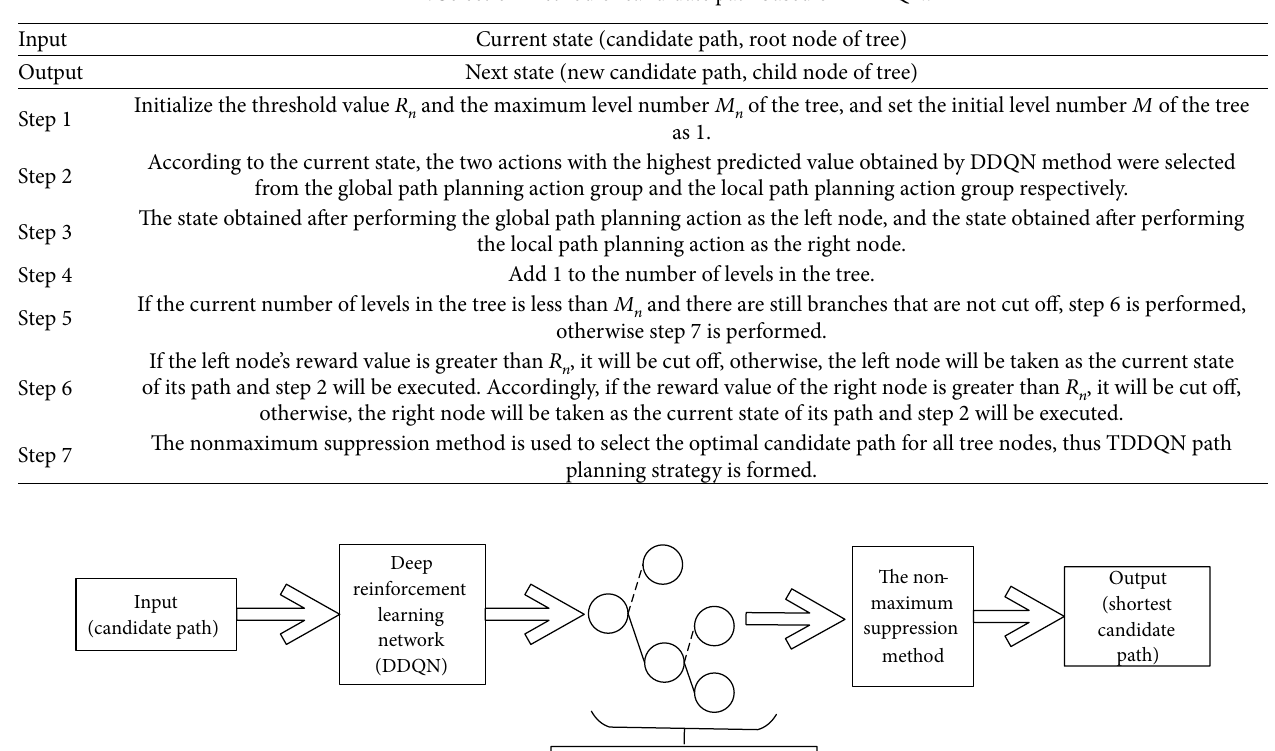
Table 1: Selection method of candidate path based on TDDQN.